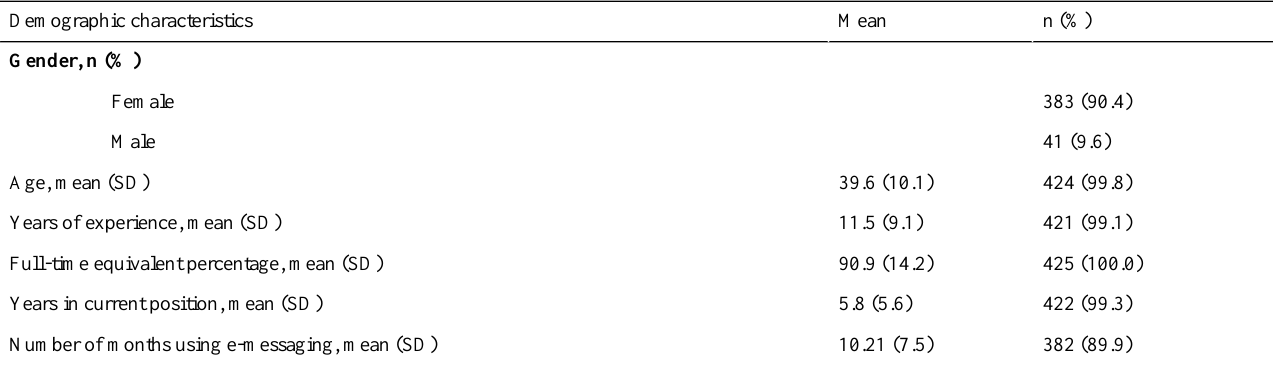
Table 1. Demographic information of home health care nurses (N=425).